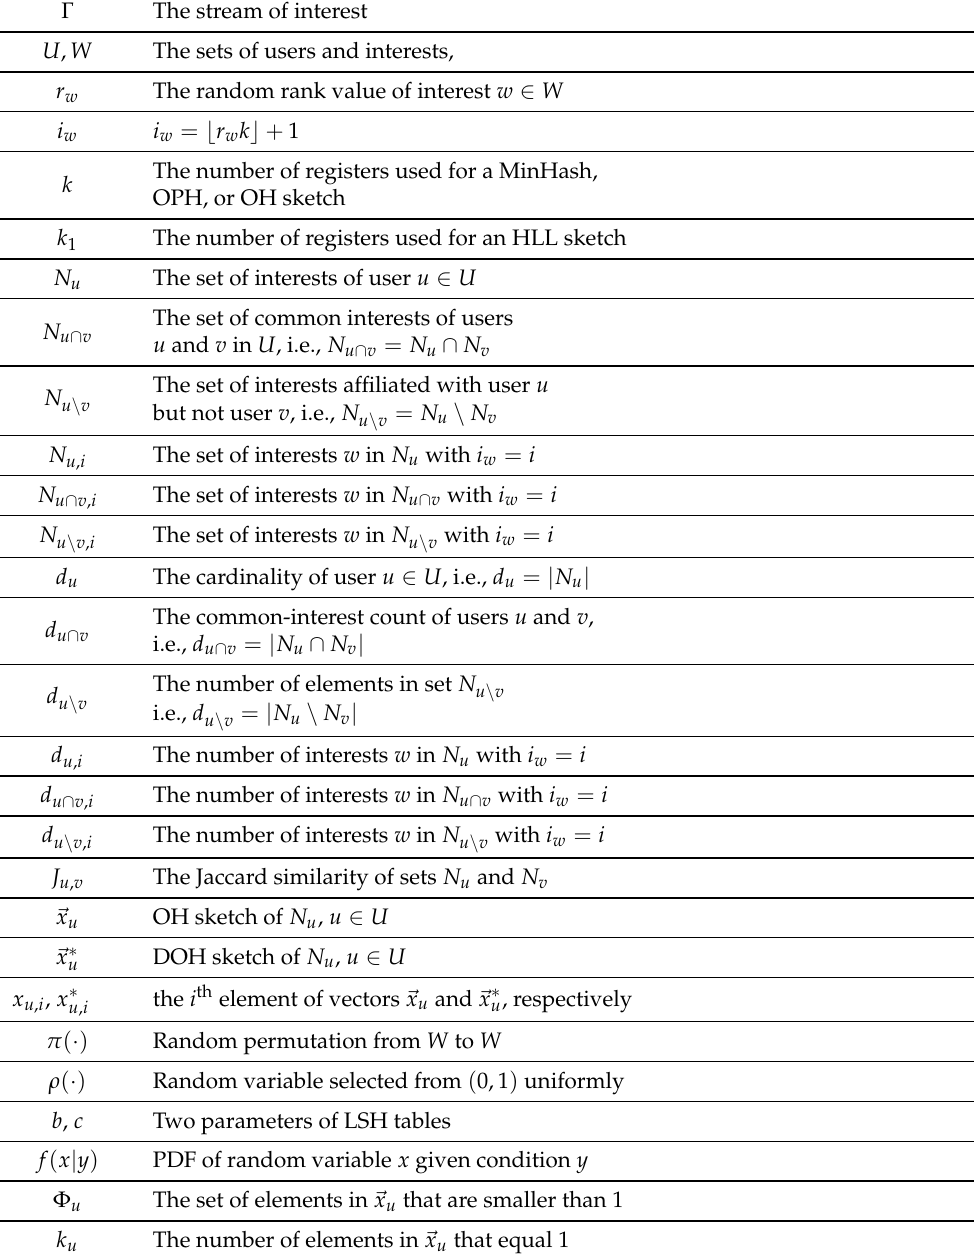
Table 1. Table of